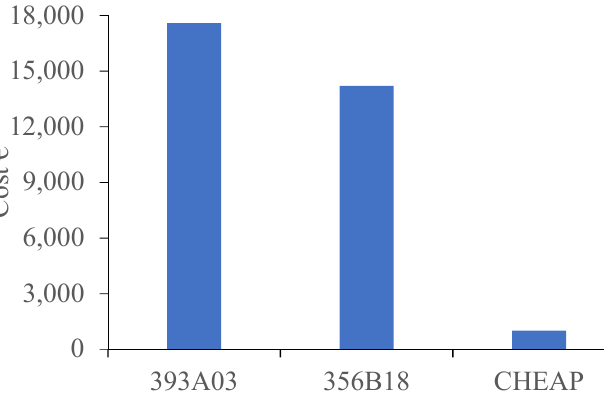
Figure 7. Price comparison of CHEAP with control systems.